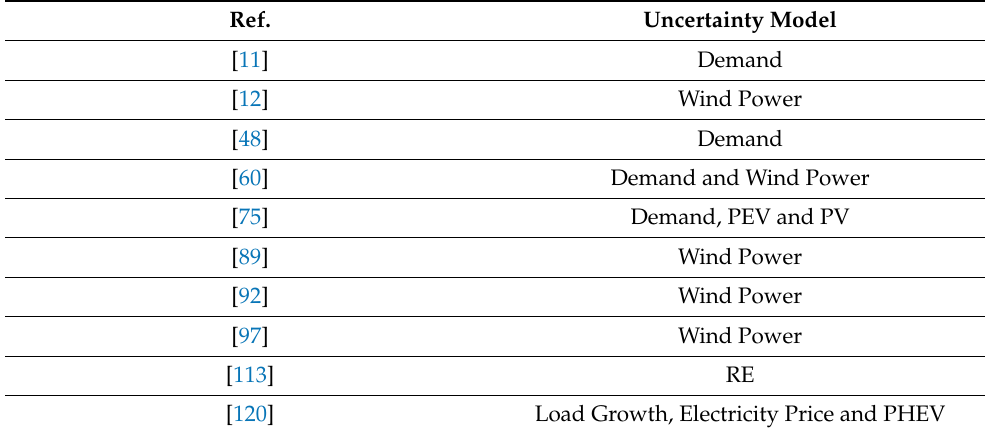
Table 8. Studies In Which MCS Is Used.